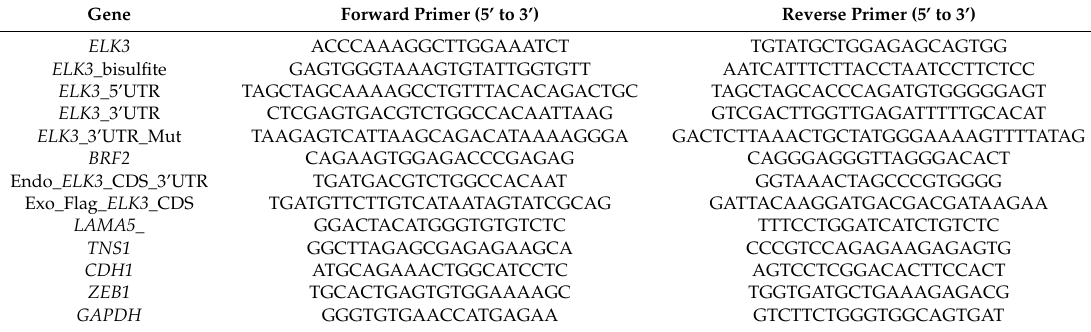
Table 1. Primer lists for